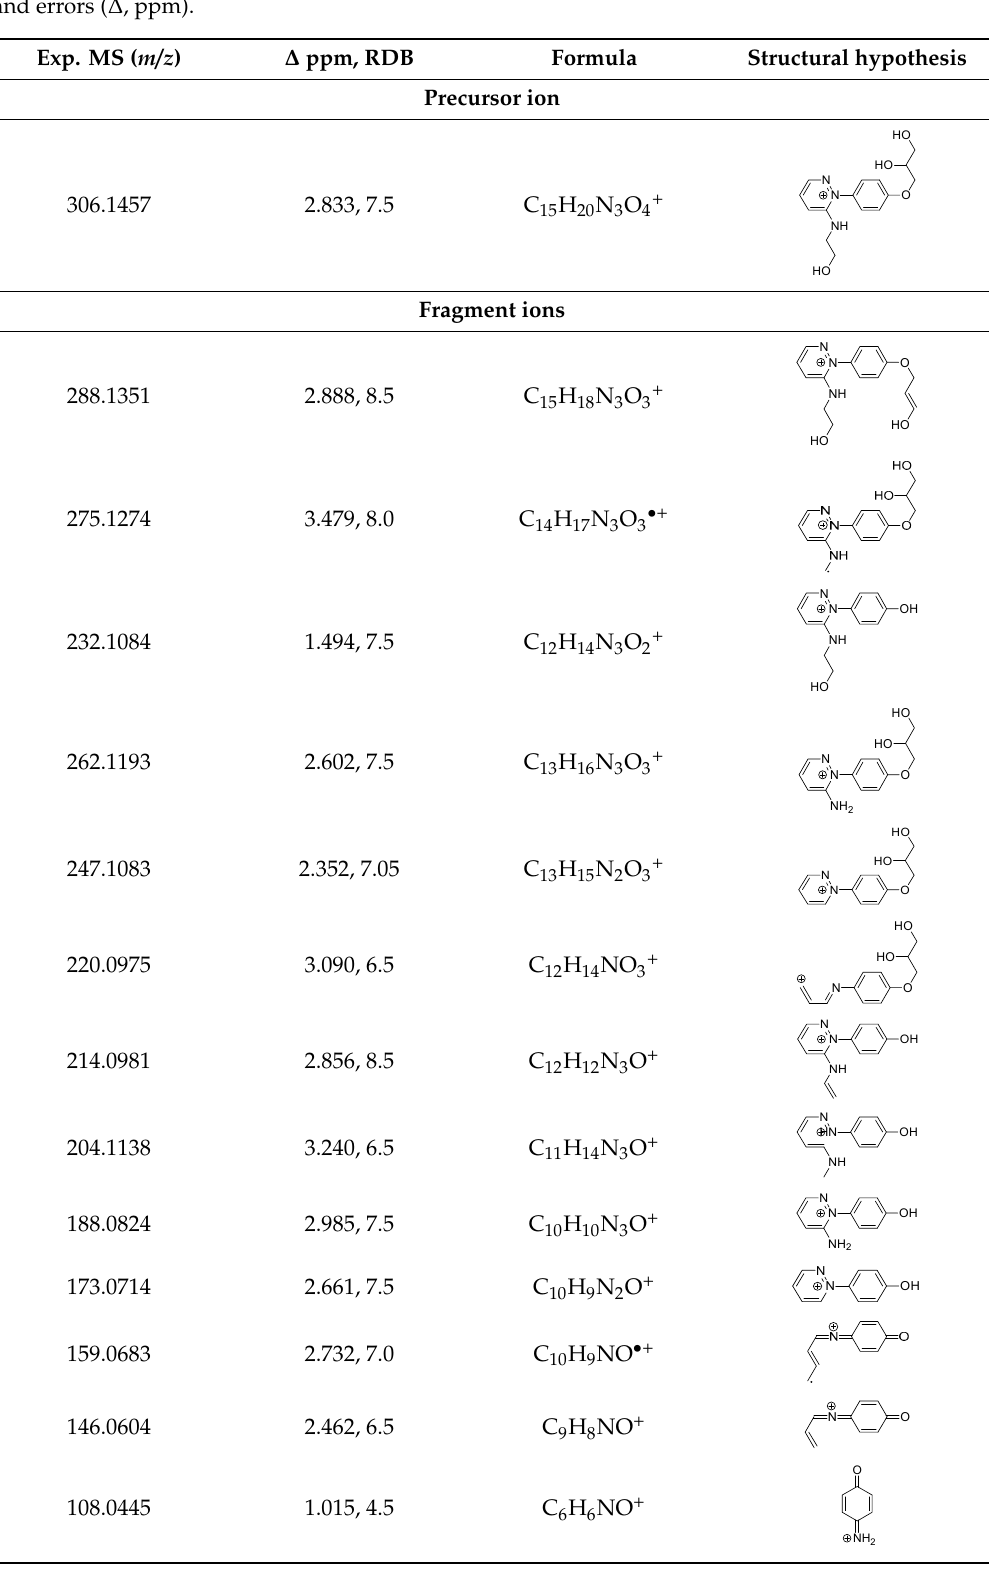
Table 2. Assignment of fragment ions contained in the HR CID MS 2 spectrum of compound 1 . Elemental formulae of the mono-isotopic ion peaks ( m/z ) are reported with double bond/ring equivalents (RDB) and errors ( Δ , ppm).